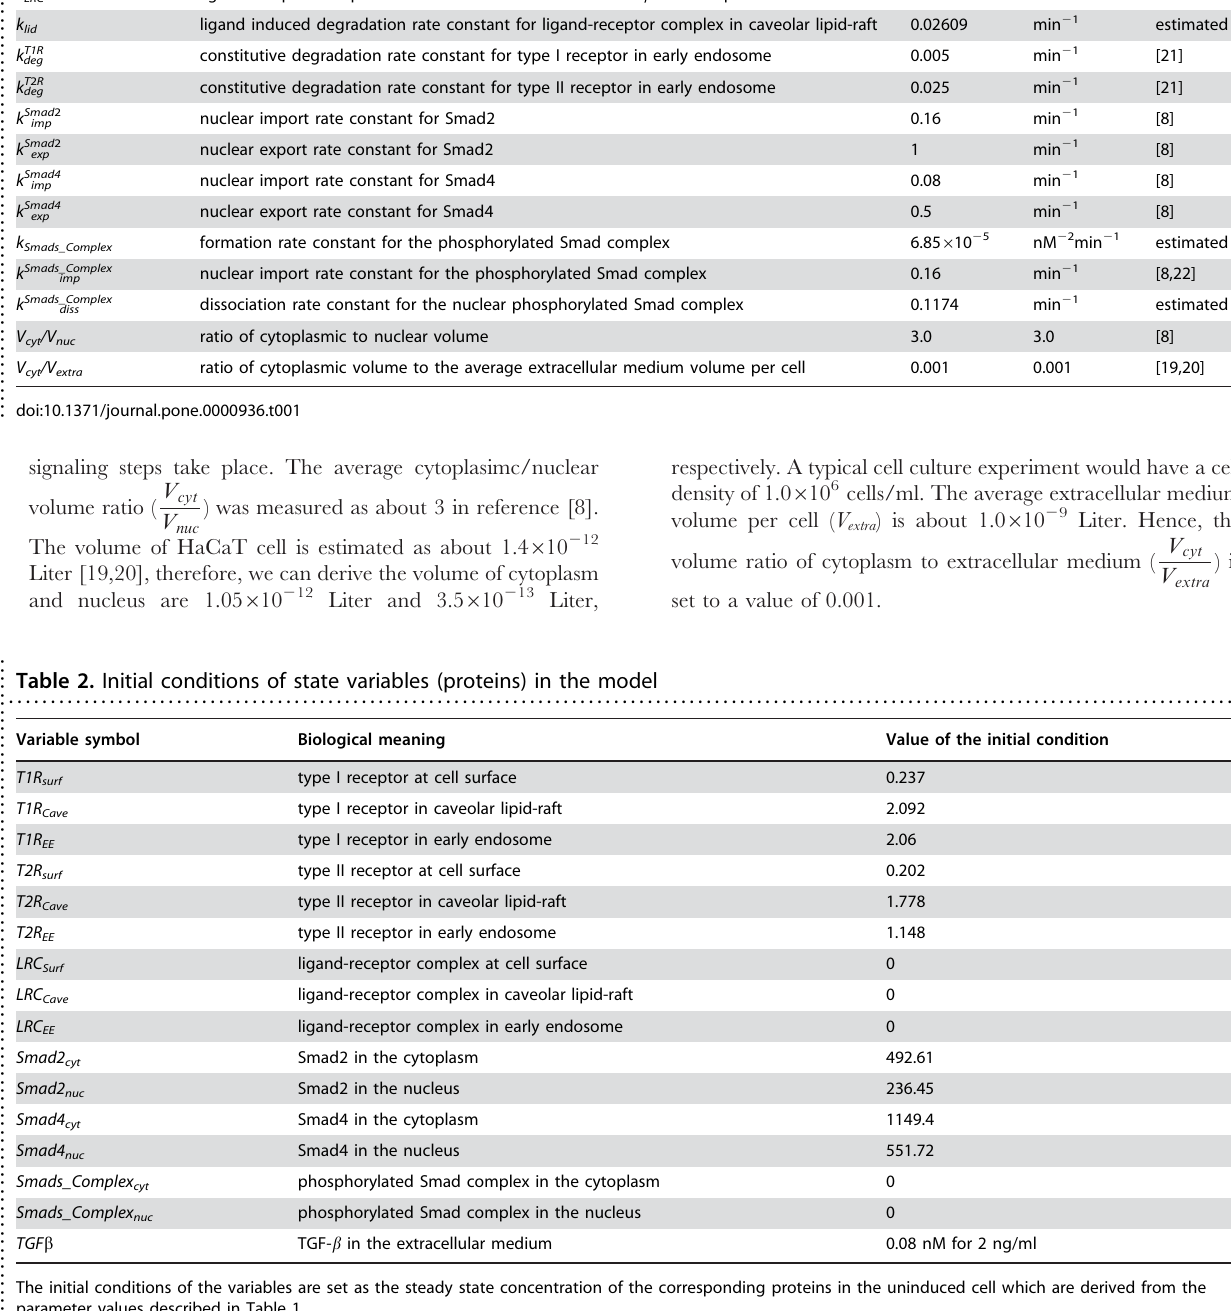
Table 1. Parameter values in the model .. ... .... ... ... .... ... ... .... ... ... .... ... ... .... ... ... .... ... ... .... ... ... .... ... ... .... ... ... .... ... ... .... ... ... .... ... ... .... ... ... .... ... ... . Parameter symbol